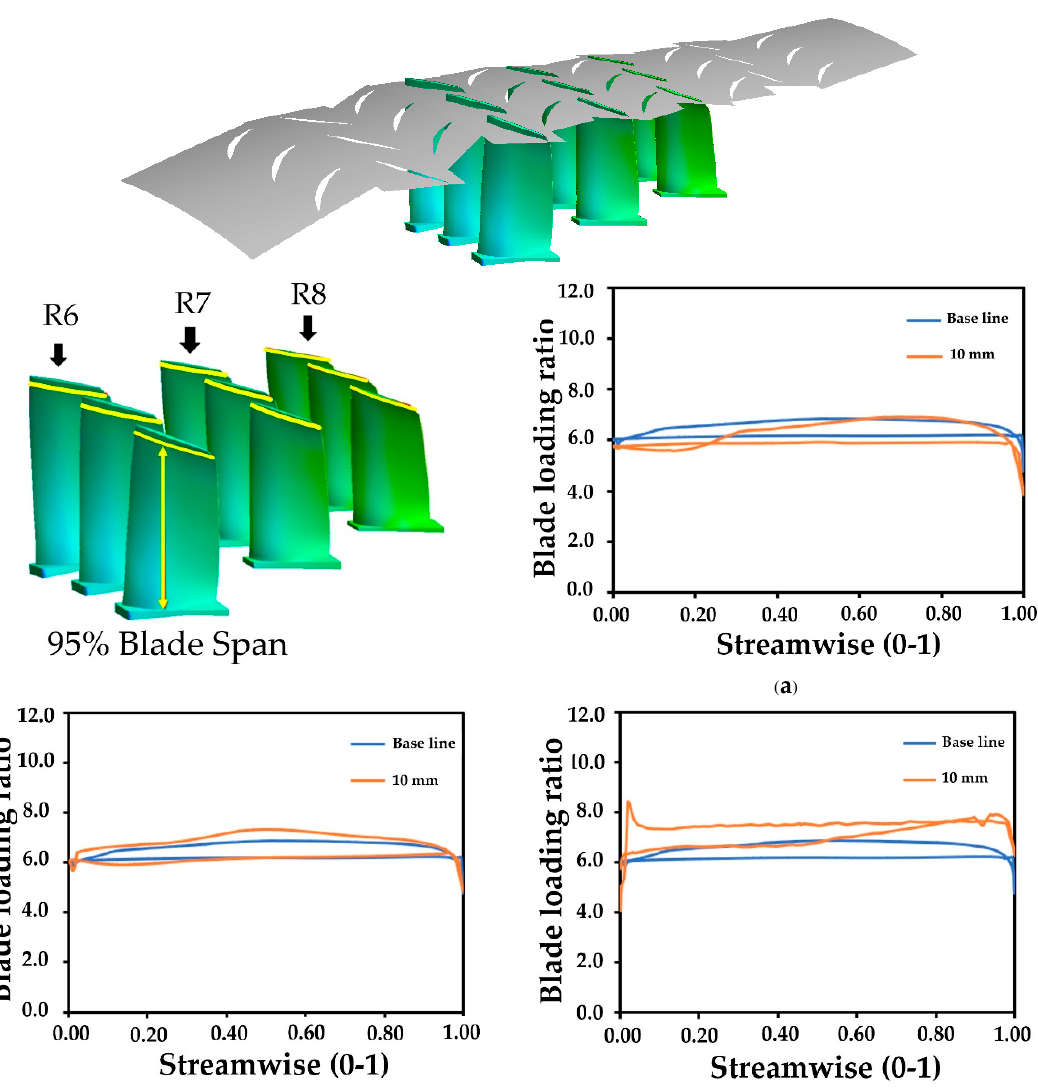
Figure 12. Blade loading ratio at 95% Blade Span ( a ) R6, ( b ) R7, and ( c ) R8.